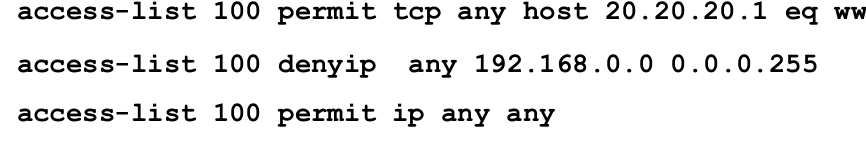
Figure 5. ACL configuration on external interface of the home gateway.